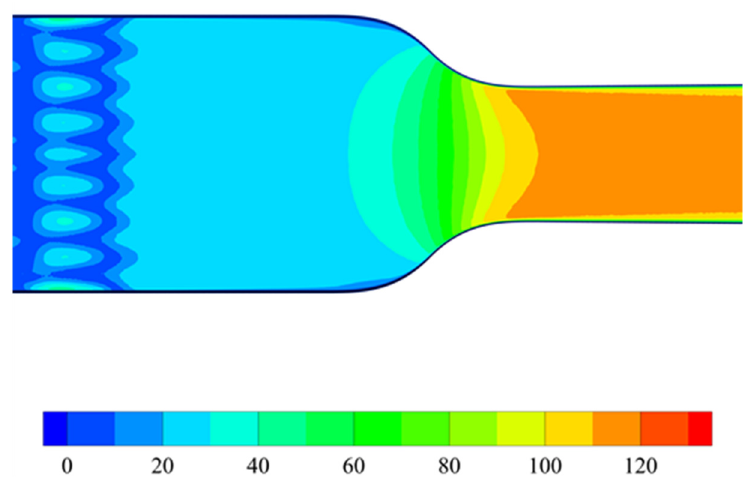
Figure 14. Velocity distribution of the gas phase (m/s).